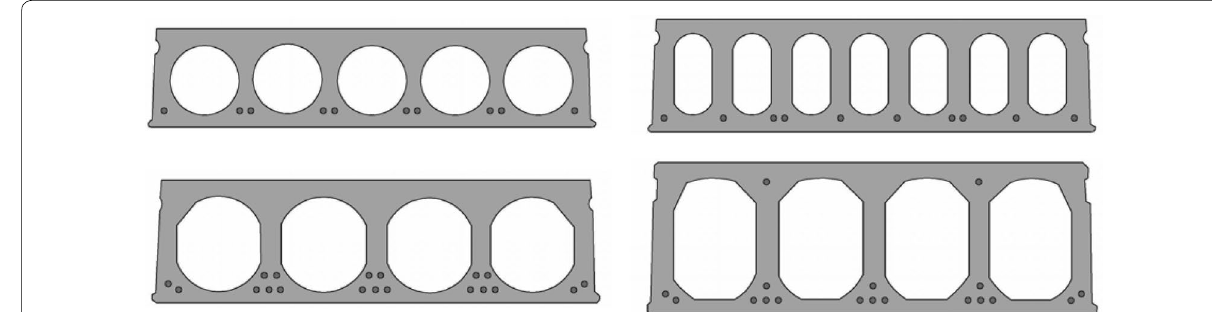
Fig. 1 Various types of prestressed hollow‑core slab.